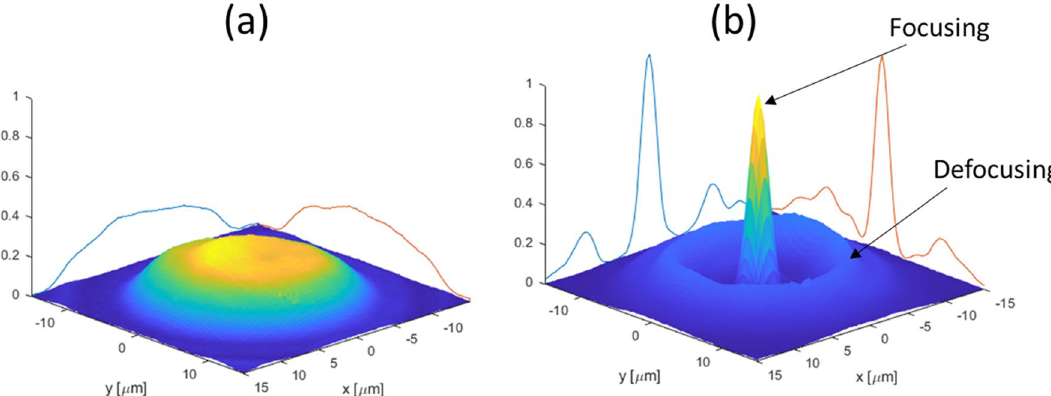
Figure 3. Focusing demonstration. Images of the probe beam’s PSF in the silicon are shown, without the pump ( a ), and with the pump beam ( b ). The trace of the donut ring of the pump laser spot in the silicon is clearly seen in ( b ) as a groove of ∼ 5 µm radius that blocks the probe IR beam completely via the FCCs absorption. Inside the donut, one may see the focused part, and outside of it is the defocused part of the IR probe beam. The practical result, in this case, is a narrower PSF probe’s spot which is narrowed by a factor of ∼ 7 and became higher by a factor of more than 2. The wavelength of the pump beam is 0.775 µm and the IR probe beam is 1.55 µm. The pulse repetition rate is 100 kHz.